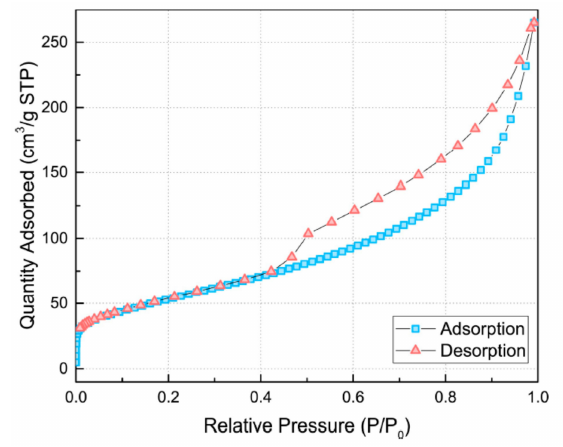
Figure 5. N 2 adsorption isotherm for the hydrothermally synthesized